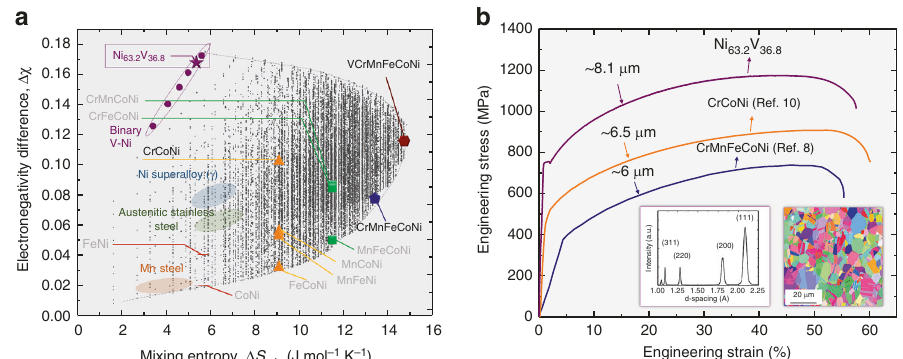
Fig. 4 Customizing solid-solution strength in CCAs via manipulation of electronegativity difference. a A complexity map based on the electronegativity difference Δχ and the mixing entropy Δ S mix for the prediction of solid-solution strengthening. All possible combinations of 3d transition metal elements (V, Cr, Mn, Fe, Co, Ni) with average VEC > 7.5 are included. The positions of the commercial alloy systems such as FeMn steel, FeNiCr steel, and γ matrix of Ni-based superalloy are shown in the diagram. Binary NiV solid-solutions are indicated in purple. b Tensile behavior of NiV CCA compared to various single-phase CCAs. The tensile stress-strain curves of single-phase equiatomic CrMnFeCoNi 8 and CrCoNi 10 are also shown here. The inset shows that NiV CCA has single fcc phase (high energy X-ray diffraction pattern) with the average grain size of 8.1 μ m (Inverse pole fi